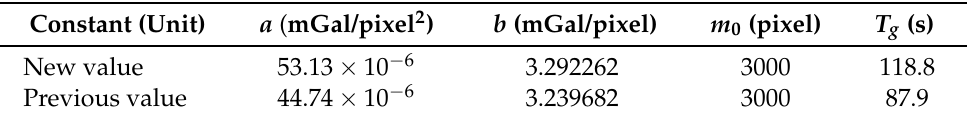
Table 1. Values for the constant parameters in Equation